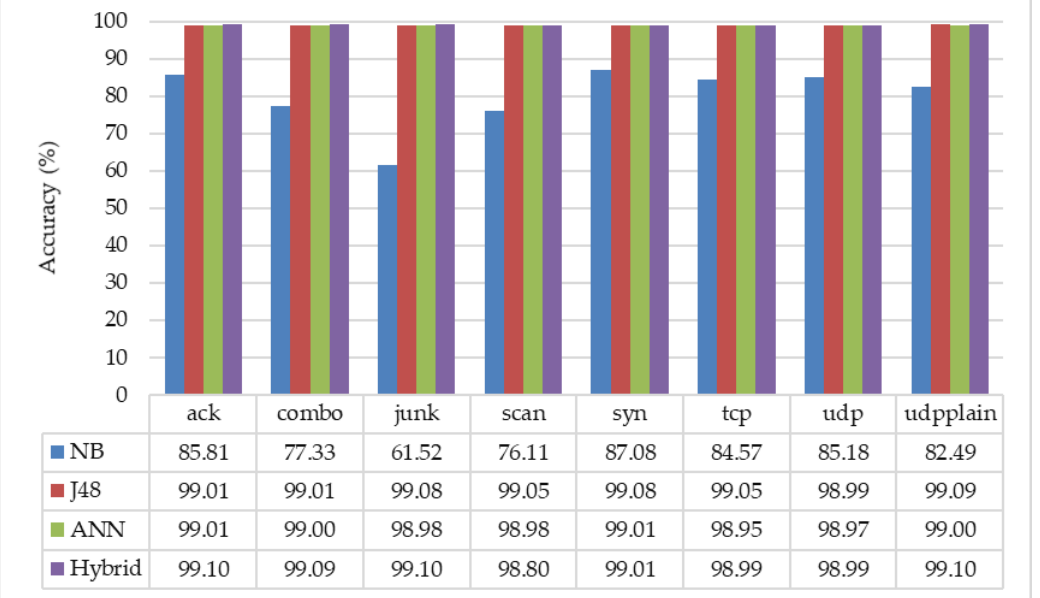
Figure 6. Comparison of our proposed sequential detection scheme (hybrid classifier) with the formal detection scheme (naïve Bayes (NB), J48, and artificial neural network (ANN)).